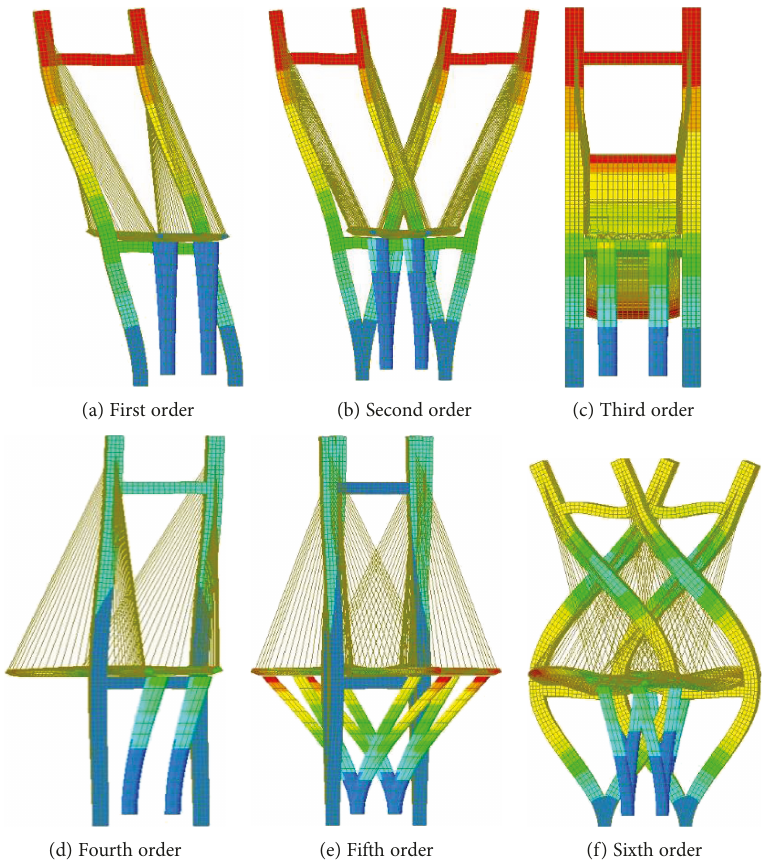
Figure 4: Modal vibration shapes of top 7 orders for long-span